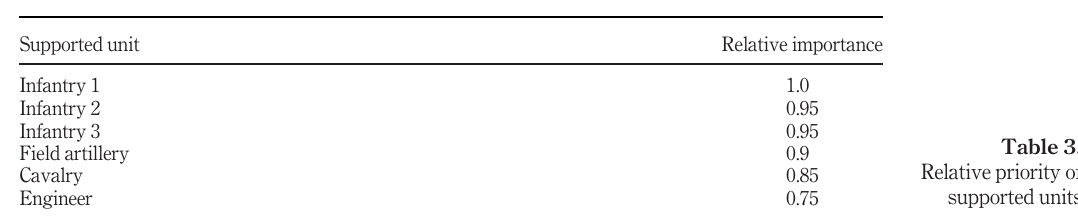
Table 3. Relative priority of